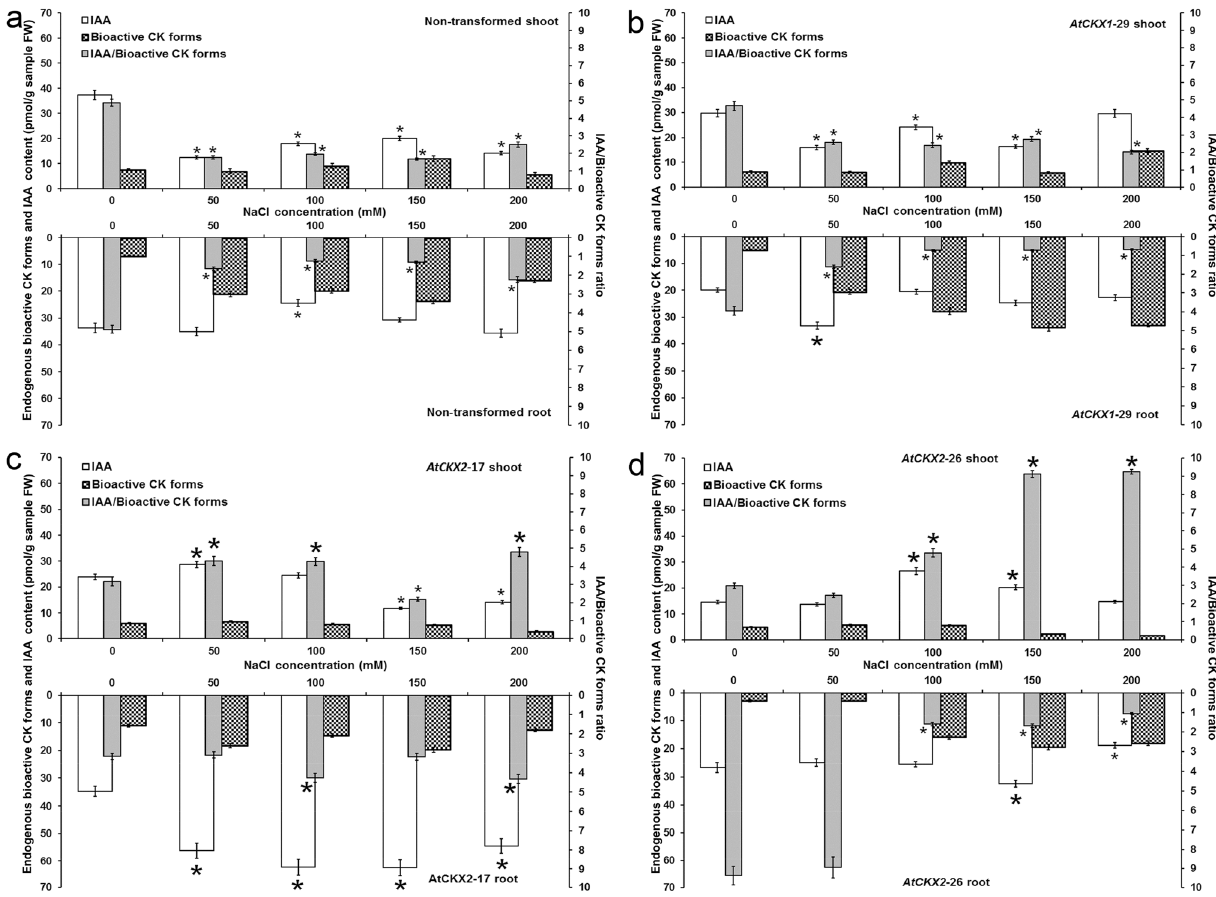
Figure 5. Endogenous IAA and bioactive cytokinin contents and their ratios in shoots and roots of 8-week-old non-transformed ( a ), AtCKX1 -29 ( b ), AtCKX2 -17 ( c ) and AtCKX2 -26 ( d ) transgenic Centaurium erythraea lines. Data represent mean ± standard error. Means marked with asterisks are significantly different from corresponding control values (LSD test, p ≤ 0.05). The bigger asterisks represent the values significantly higher than control ones while smaller asterisks represent values significantly lower than control